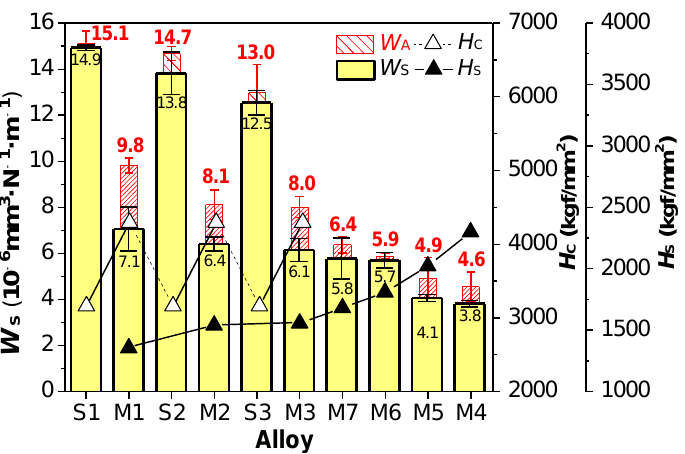
Figure 12. Relationships between wear rates W A of coated cemented carbides in NaCl aqueous solution and H C (or H S ).